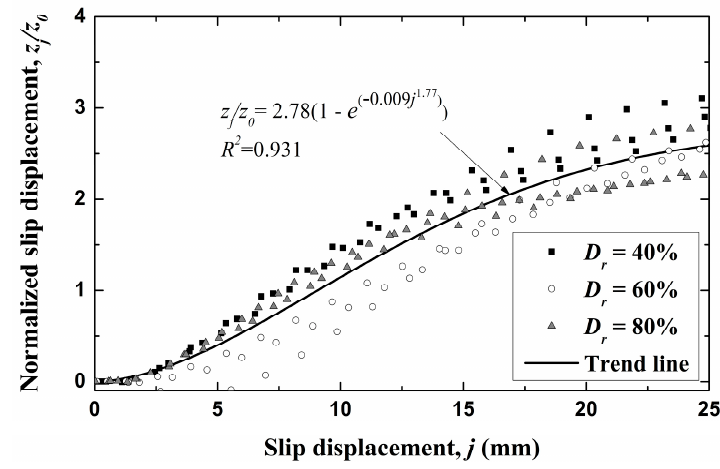
Figure 11. Curve fitting of the normalized slip sinkage and slip displacement relationships.